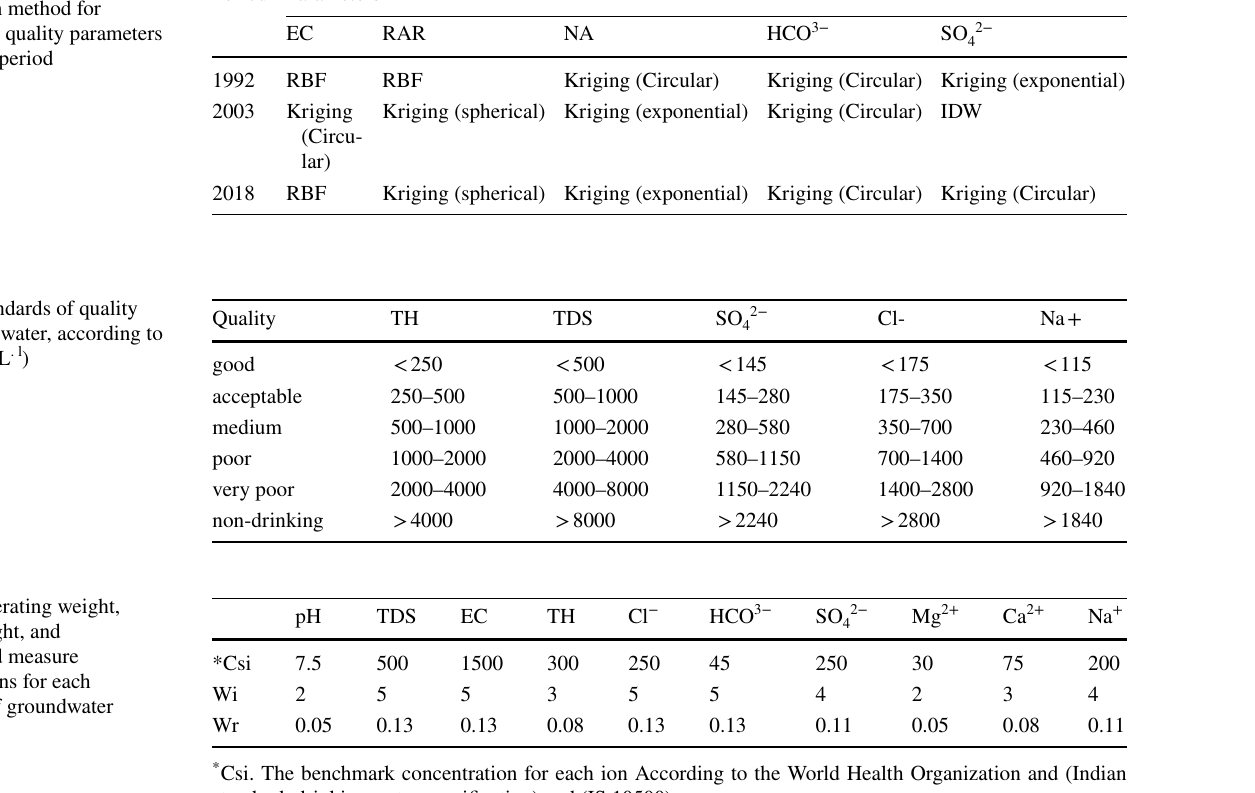
Table 2 The most suitable interpolation method for groundwater quality parameters in the given period